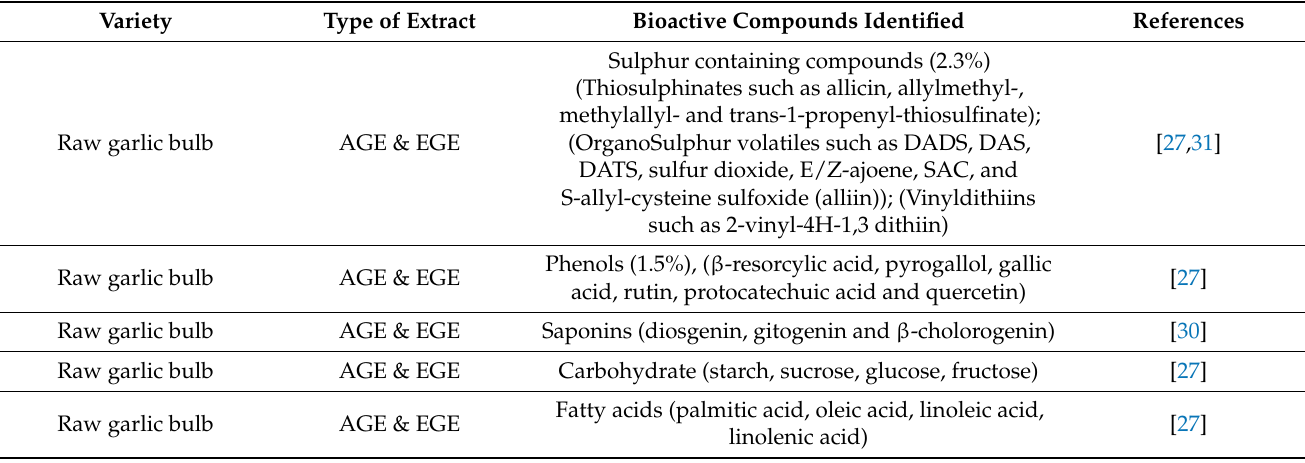
Table 1. Bioactive constituents in